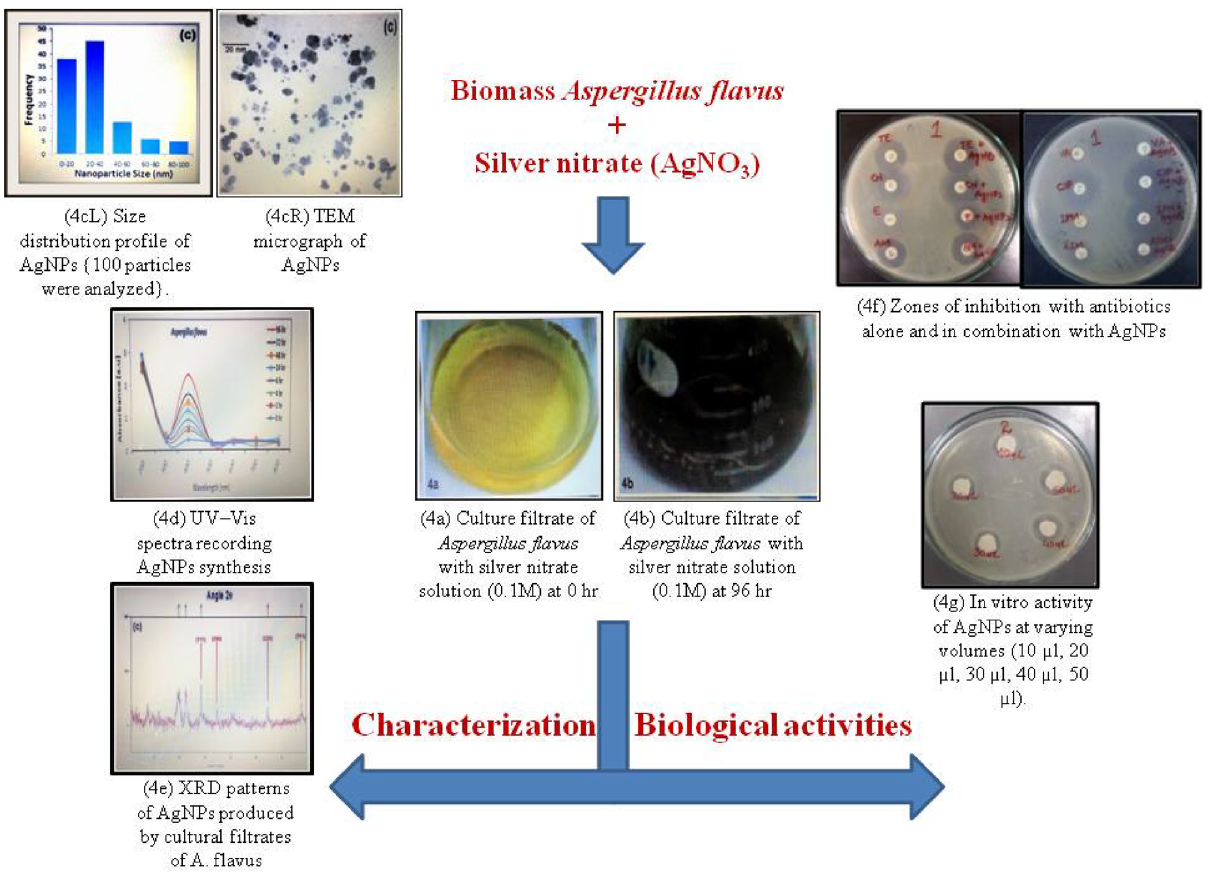
Figure 1. Biosynthesis of AgNPs from Aspergillus flavus having antibacterial activity. (4a) Culture filtrate of A. flavus with silver nitrate solution (0.1 M) at 0 h. (4b) Culture filtrate of A. flavus with silver nitrate solution (0.1 M) at 96 h. (4cL) Size distribution profile of AgNPs synthesized by cultural filtrates of A. flavus {100 particles were analyzed}. (4cR) TEM micrographs of AgNPs produced by cultural filtrate of A. flavus. (4d) UV–Vis spectra recorded for the biosynthesis of AgNPs in response to 0.1 M. silver nitrate inoculated media of A. flavus. (4e) XRD patterns of AgNPs biosynthesized by cultural filtrates of A. flavus. (4f) Zones of inhibition with antibiotics alone and in combination with AgNPs*.Antibiotics in combination with AgNPs (A and B) have a wider zone of inhibition as compared to antibiotic alone showing thereby that AgNPs conjugated to antibiotics have a stronger antibacterial potency. (4 g) In vitro activity of AgNPs* at varying volumes (10 µL, 20 µL, 30 µL, 40 µL, 50 µL). AgNPs silver Phenotype detection of carbapenemase activity. Of 255 total isolates, 61.5% were carbapenemase producers, including 32 samples from urine (45%), wound swabs n = 25 (28%), sputum n = 28 (80%), blood n = 21 (70%), tissue n = 5 (41%) and pus n = 4 (22%). Phenotypic detection of Metallo-β-lactamases was observed by CDST as per guidelines of CLSI 2019 (Fig. 3). Antibiotic susceptibility of MBL producers is illustrated in Fig. 4. Prevalence of MBL and ESBL producers in correlation with the department is shown in Table 4. Multiplex PCR for AMR genes ( bla , bla , bla , bla , bla ). Multiplex PCR detected the OXA IMP TEM SHV VIM existence of resistance genes in 52.5% (n = 80) of the ESBL producers. Expression of bla TEM was of the order 43% of ESBL producers (n = 34) whereby bla SHV was detected in 32% of isolates. Likewise, the expression of bla OXA was 21%. bla VIM along with bla IMP-1 co-existed in 11.5% of MBL producers. 57.5% ESBL-positive strains exhib- ited simultaneous existence of bla TEM , bla SHV plus bla OXA , bla TEM was concomitantly expressed with bla OXA types in 19.5% of ESBL producers whereas bla TEM simultaneously showed presence with bla SHV in 22.5% isolates. Co- existence of bla OXA plus bla SHV was found in 9.5% of isolates while bla SHV , bla TEM , as well as bla OXA subsisted in 7.5% of ESBL-producers. Expression of bla AmpC was positive in 15% of isolates that were cefoxitin resistant. The correlation between phenotypic and genotypic MDR has been tabulated in Table 5. The co-expression of various genes is depicted in Fig. 5. MIC of MBL producing Pseudomonas aeruginosa . The MIC of imipenem against 10 (13%) bla IMP - producing Pseudomonas aeruginosa isolates inhibited five isolates at 16 μg/mL and five other isolates at 8 μg/mL. The MIC of imipenem for 12 (15%) bla VIM -producing Pseudomonas aeruginosa was 16 μg/mL, for three isolates